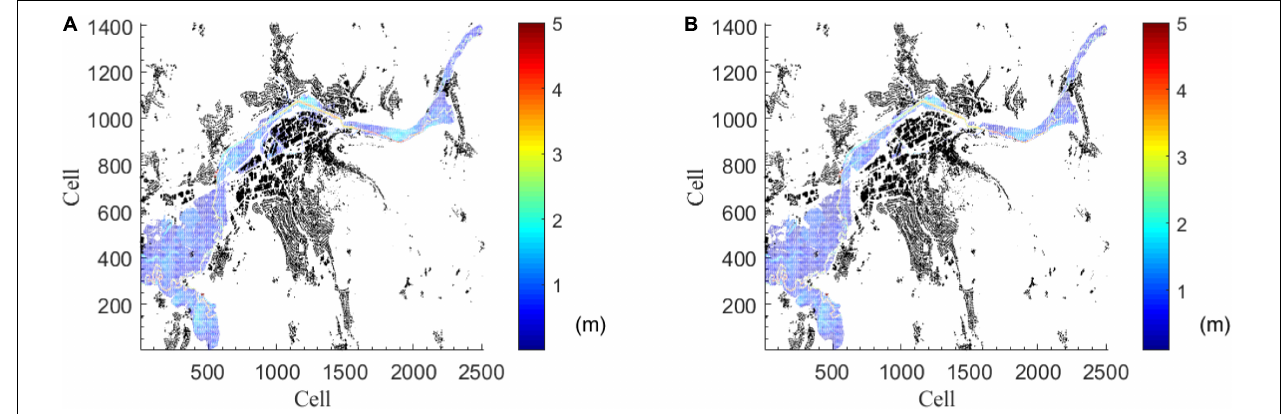
FIGURE 9 | Example of flood inundation prediction in testing dataset (Event #180). Black parts are houses. (A) Inundation prediction from ANN model. (B) Inundation prediction from the database.